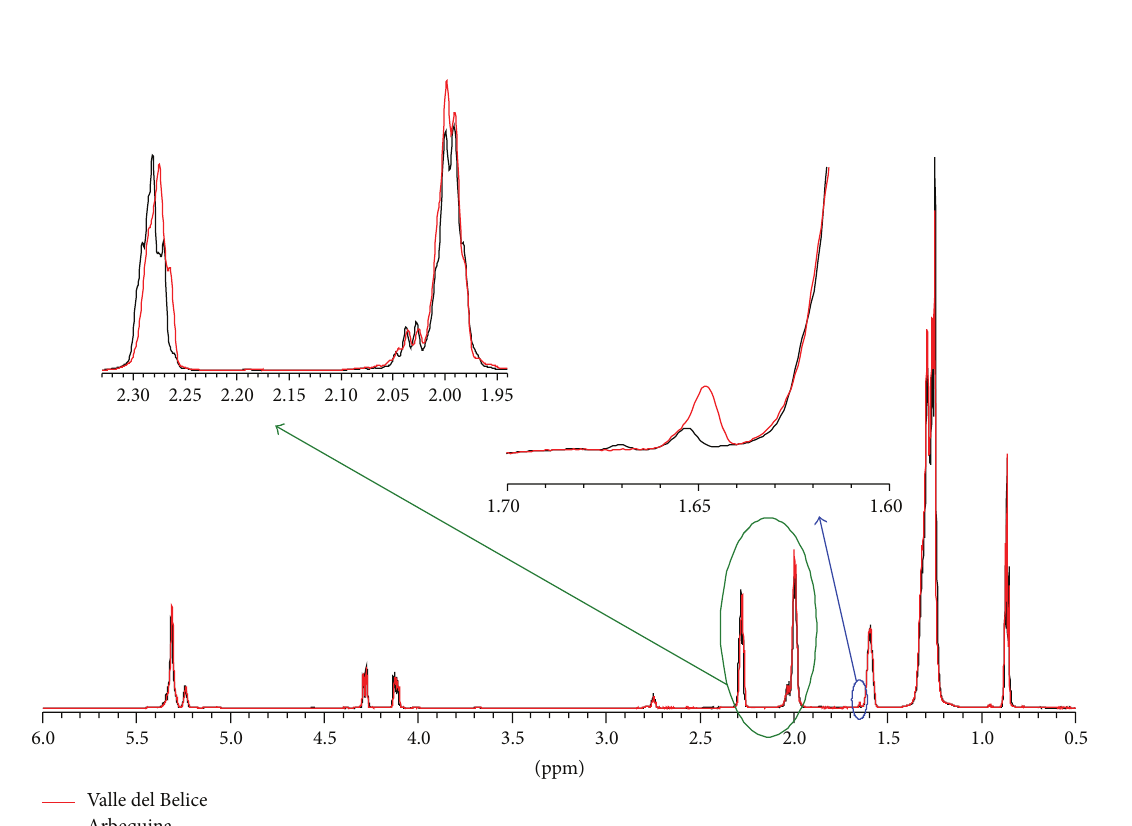
Figure 8: The comparison between the HR-MAS NMR spectra of Arbequina and Valle del Belice cultivars. The expansion on the left side (greenarrow)showsthatthepeakatabout2.83 ppmhasthesameintensityforthetwocultivars,whereasthoseatabout2.02 ppmand2.83 ppm are more intense for the Valle del Belice sample rather than for